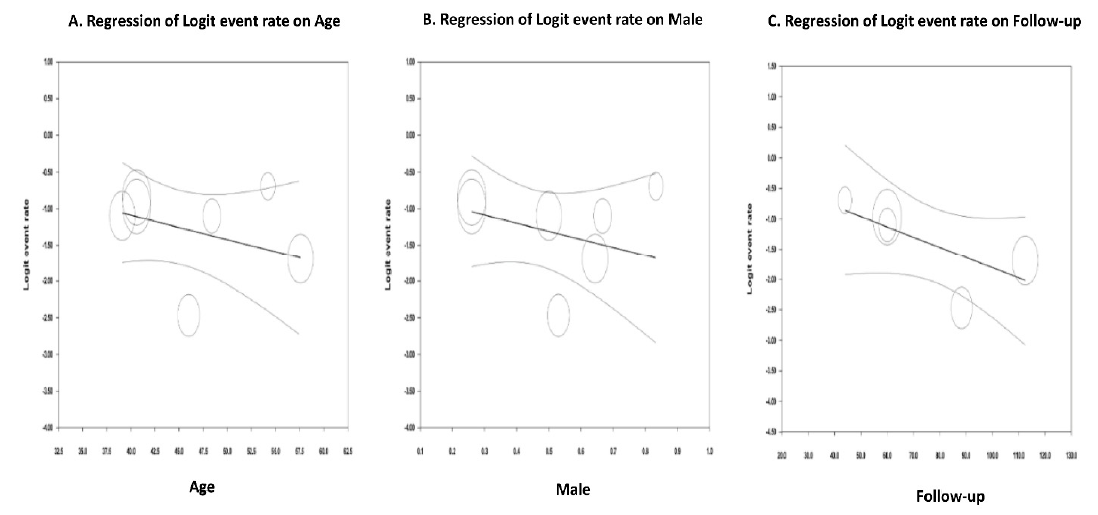
Figure 4. Scatter plot from meta-regression analysis on ( A ) age, ( B ) male sex, and ( C ) follow-up. Evaluation for Publication